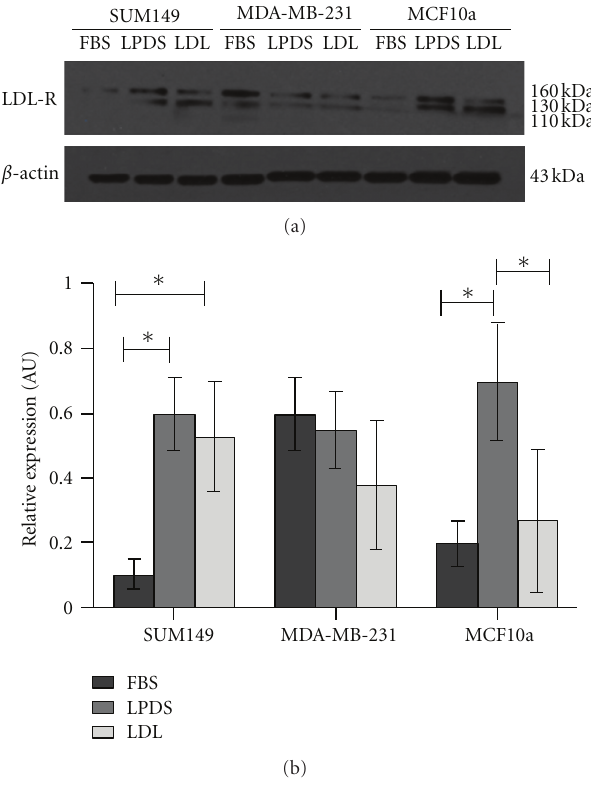
Figure 3: Western blot analysis of LDL-R protein expression. (a) Is a representative immunoblot for LDL-R and β -actin. The protein- specific bands separate at 160, 130, and at 110kDa, according to the producer’s specifications. (b) Relative LDL-R protein expression in SUM149, MDA-MB-231, and MCF10a cells as a result of FBS, LPDS, and LDL treatments. Densitometry was performed and data is presented as expression relative to β -Actin loading controls ( ∗ P < 0 . 01). Error bars represent S.E.M. and all experiments were performed at least three separate